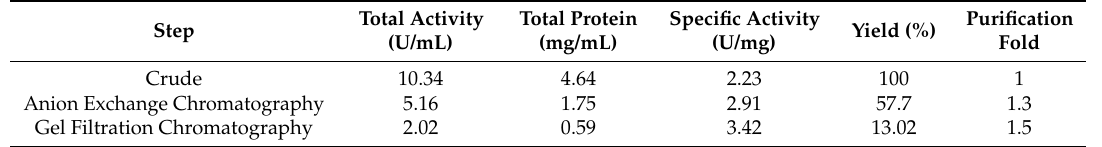
Table 1. Purification of catechol 1,2-dioxygenase (C12O) from Pseudomonas chlororaphis strain UFB2 ( Pc